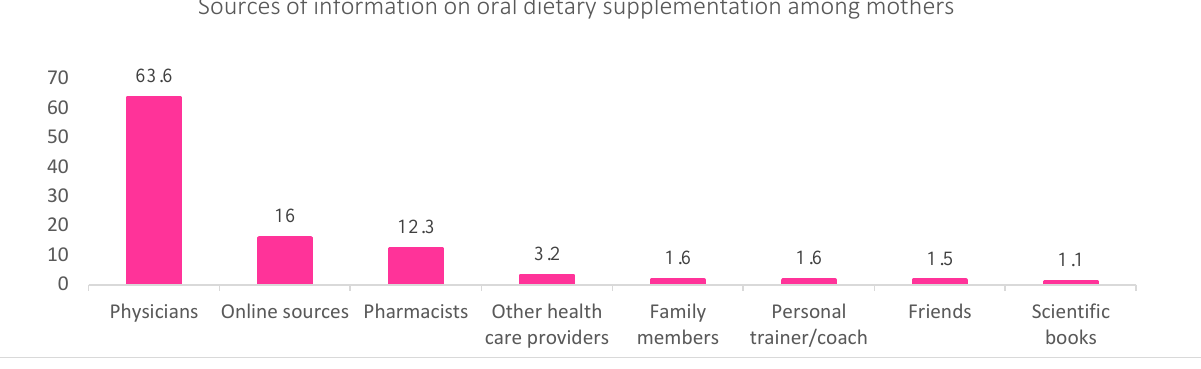
Figure 4. Mothers ’ sources of information on oral dietary supplementation. Figure 4. Mothers’ sources of information on oral dietary